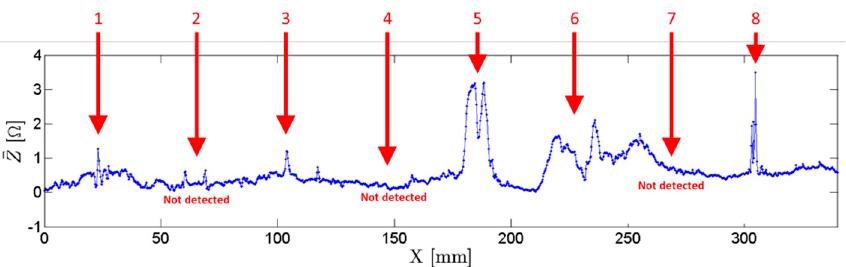
Figure 13. Customized EC probe output signal operating at a frequency of 750 kHz. Defects 1 to 8, as presented in Table 1.